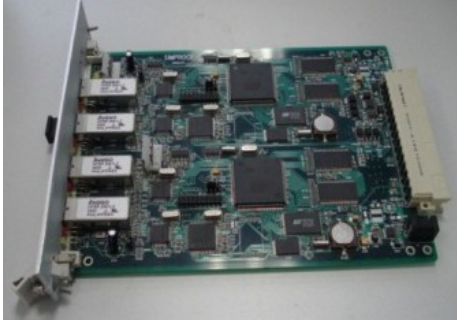
Figure A8. Photograph of main control board in ECP plus.